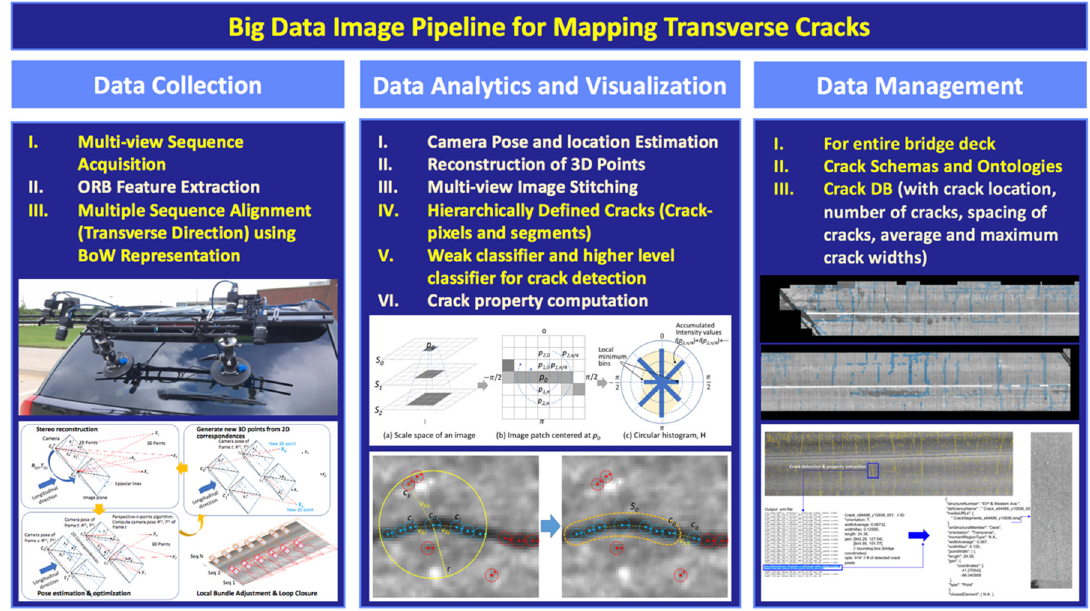
Figure 1. Overall process of the image-based data processing pipeline.